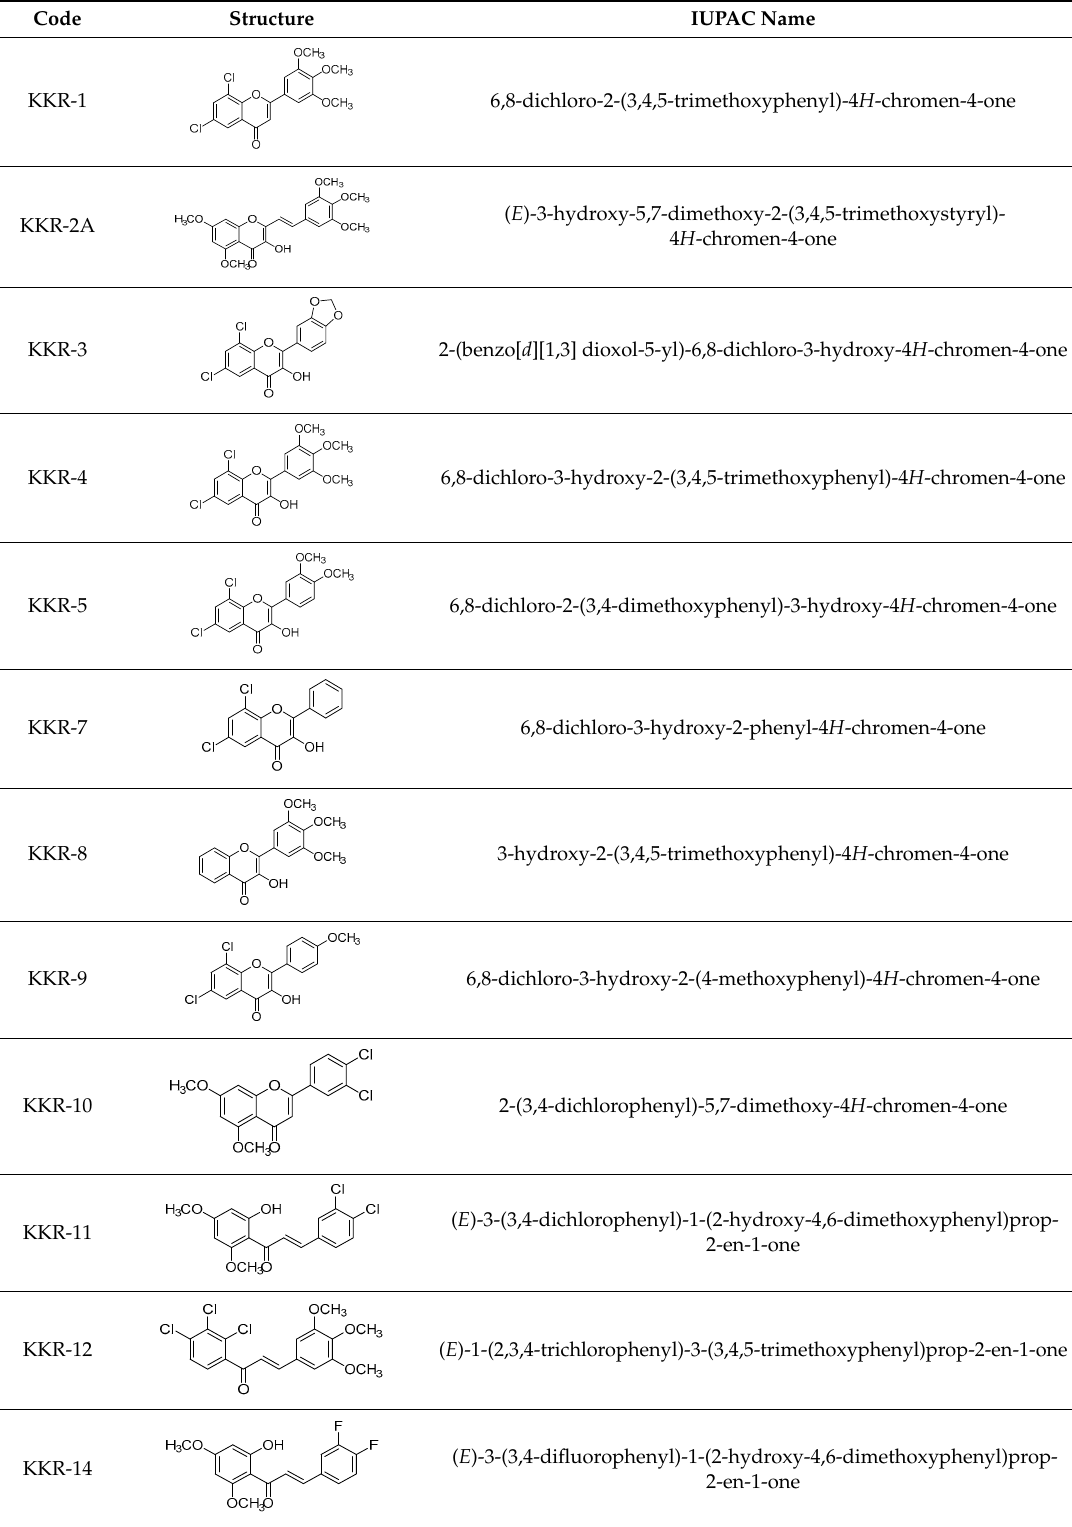
Table 1. A series of twenty KKR flavonoid derivatives synthetic structures and their IUPAC names; eleven flavones: KKR1, KKR3, KKR4, KKR5, KKR7, KKR8, KKR9, KKR10, KKR19, KKR21, and KKR22; two chromones: KKR16 and KKR2A; and seven chalcones: KKR11, KKR12, KKR14, KKR17, KKR18, KKR20, and KKR23.